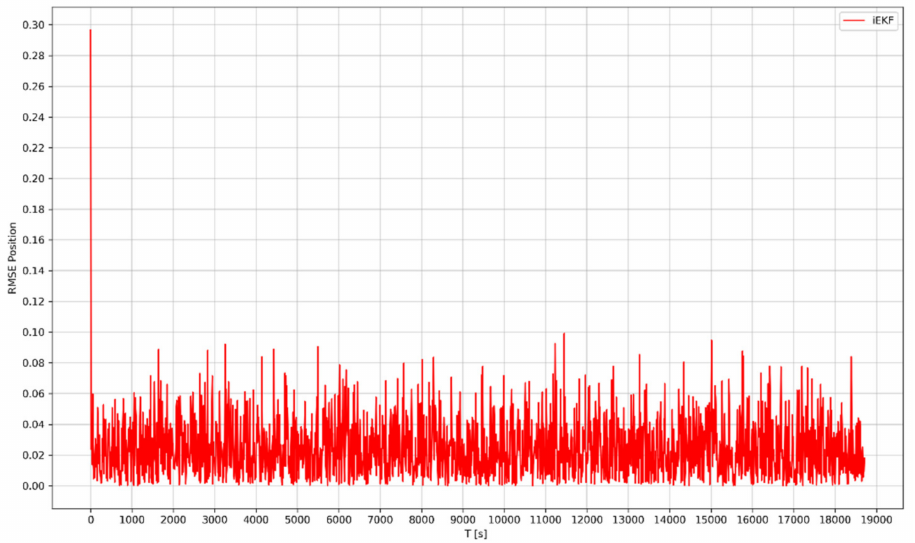
Figure 15. Case 2: iEKF RMSE for the